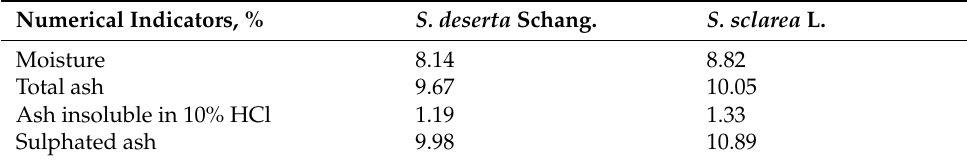
Table 1. Numerical indicators of the studied plant species. Numerical Indicators, %